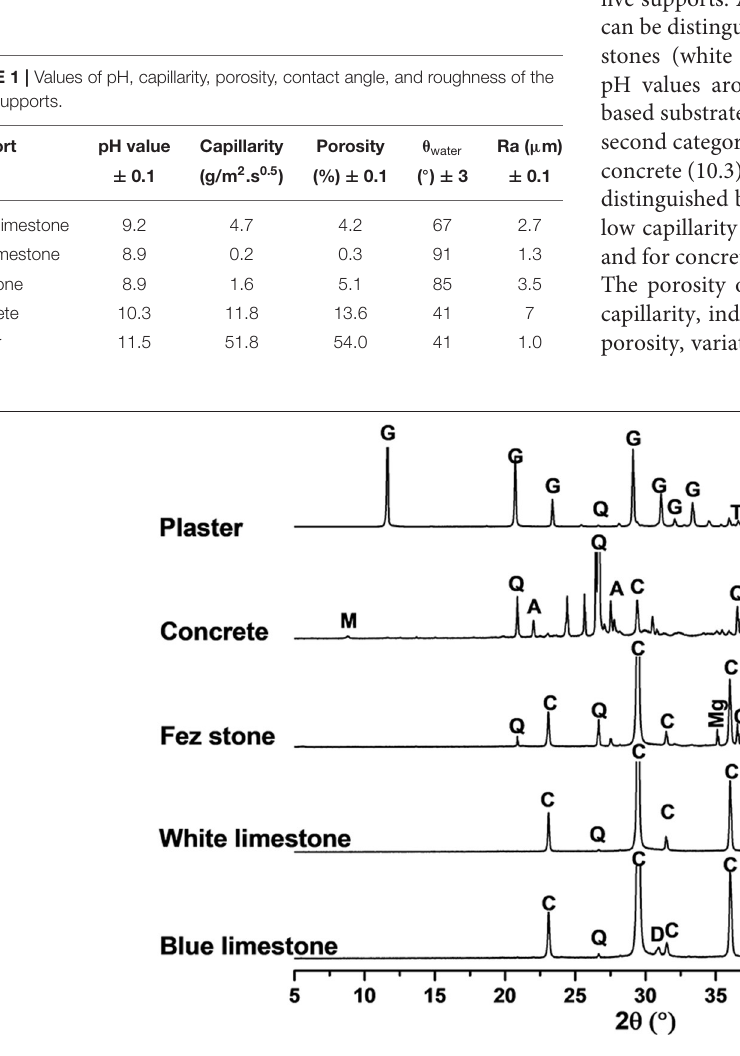
FIGURE 1 | XRD patterns of the blue limestone, white limestone, Fez stone, binder, and plaster. JCPDS files (C: Calcite 04-012-0489), (D: Dolomite 04-011-9828), (Q: Quartz 00-046-1045), (Mg: Potassium Magnesium Oxide 01-071-3699), (G: Gypsum 00-033-0311), (Ti: Rutile 00-016-0934), (M: Muscovite 0-001-1098), and (A: A/bite